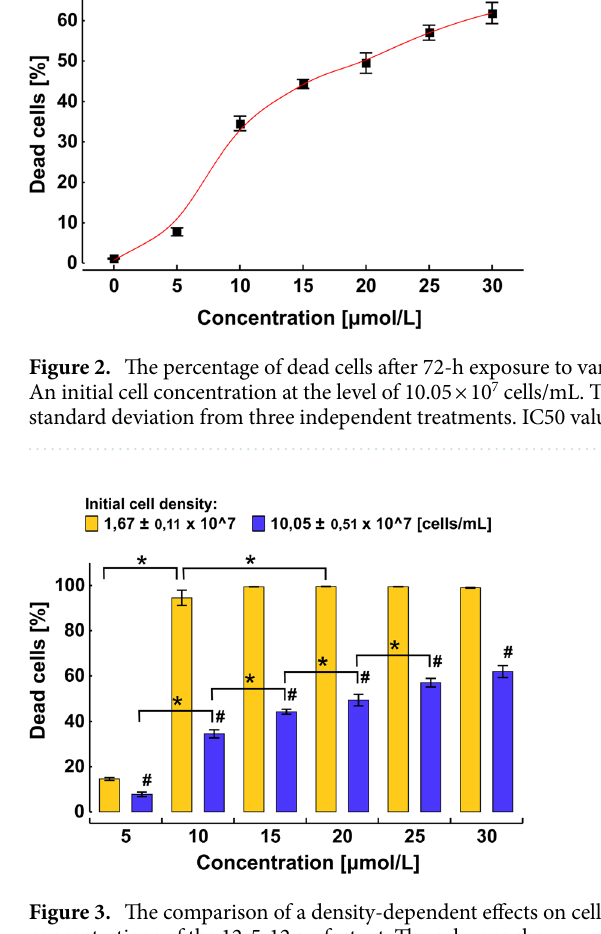
Figure 3. The comparison of a density-dependent effects on cell viability of 72-h exposure to various concentrations of the 12-5-12 surfactant. The columns show mean values and the error bars represent a standard deviation from three independent treatments. Statistical significance was assessed with the two-way ANOVA followed by the post-hoc Tukey’s honestly significant difference (HSD) test. An asterisk indicates statistically significant differences between the compound concentrations and a number sign points to statistically significant differences between the various cell densities (p <